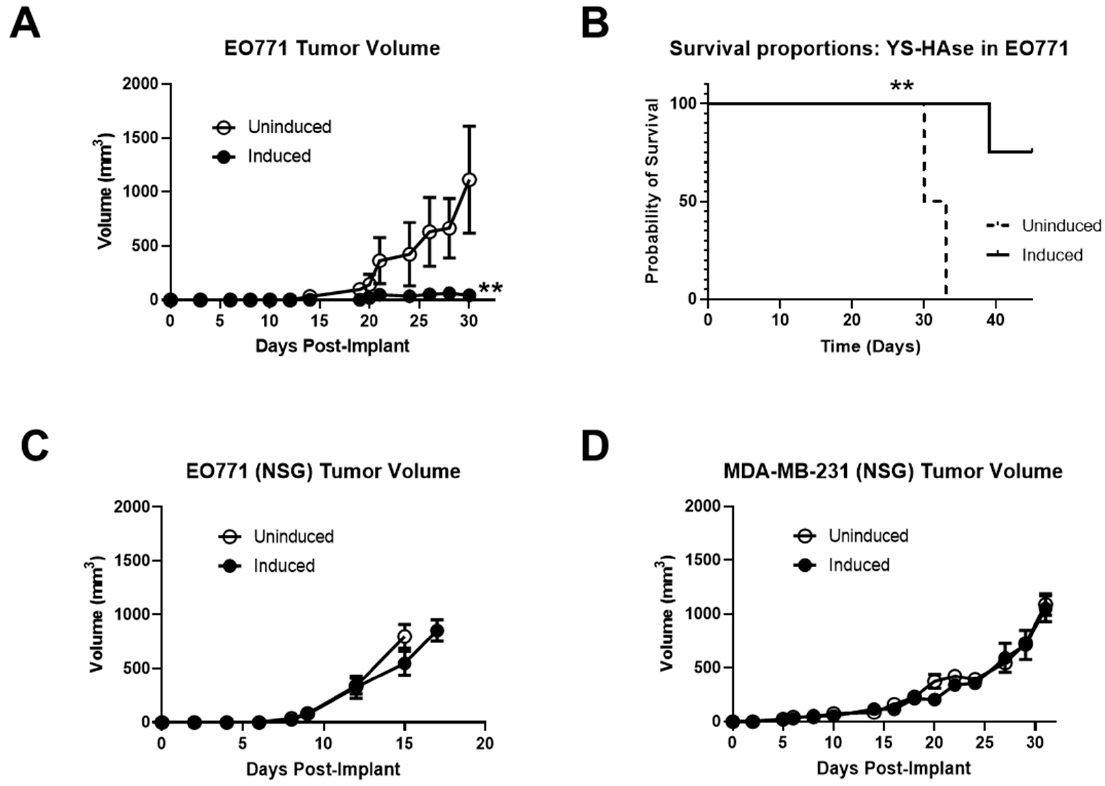
Figure 6. YS-HAse controls EO771 tumor growth and improves survival in an immunocompetent murine model. ( A ) C57BL/6 mice bearing orthotopic EO771 tumors (>50 mm 3 ) were administered 5 × 10 6 cfu per day of YS-HAse by i.v. injection on two consecutive days. Forty-eight hours after the